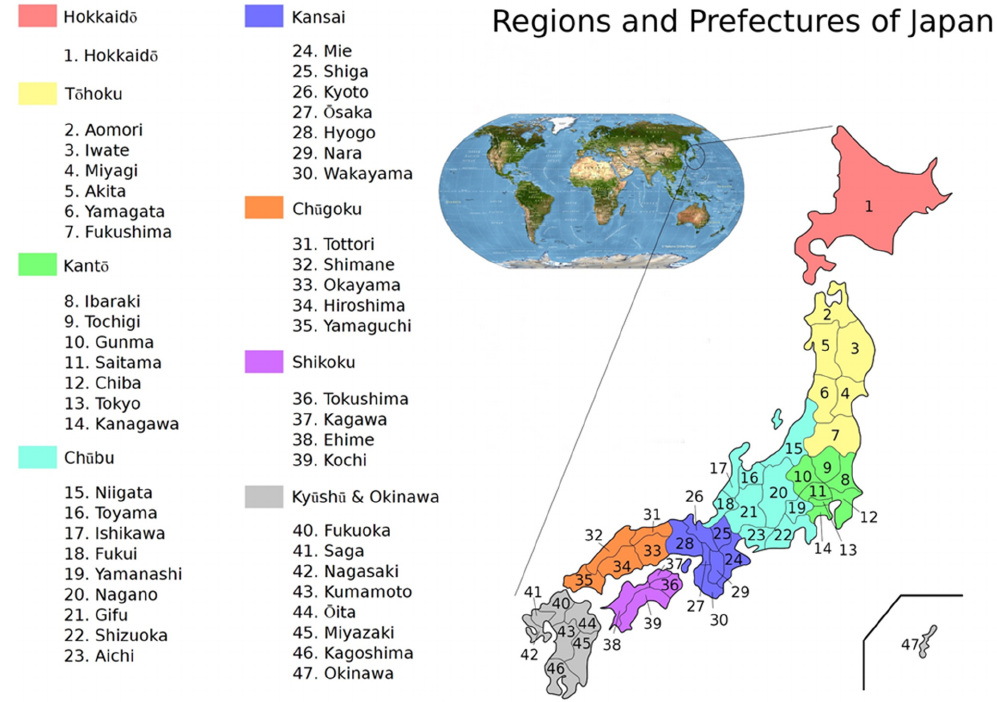
Figure 1. Map showing detailed administrative regions and the forty-seven prefectures of Japan .